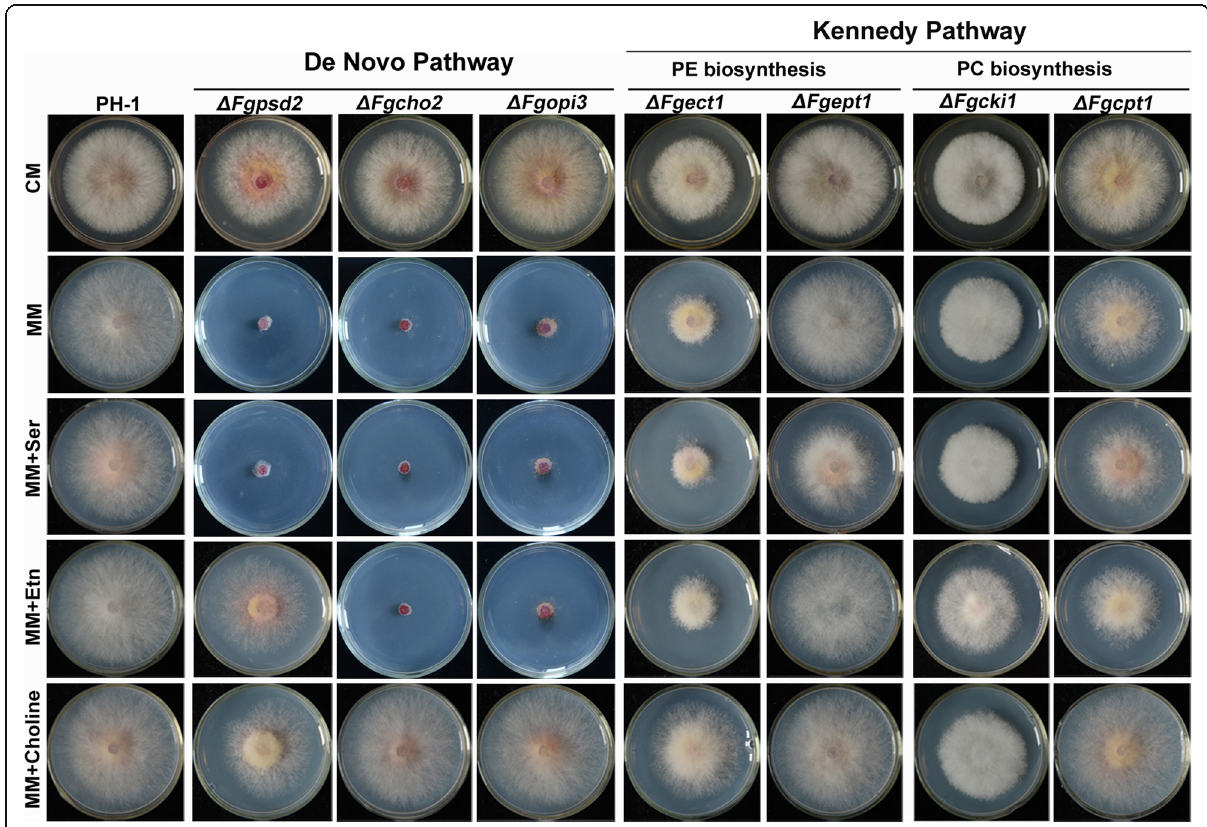
Fig. 2 Radial growth of the wild-type strain and gene deletion mutants on various media. Strains were grown on complete medium (CM), minimal medium (MM) and MM supplemented with Ser (serine), Etn (ethanolamine) or choline at 25 °C for 3